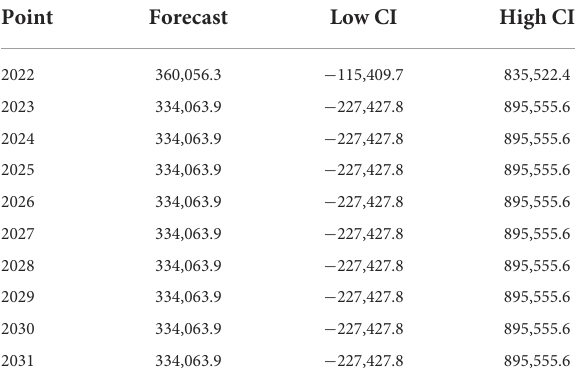
TABLE 1 Out-of-sample forecast at 95% confidence intervals of IDPs annual figures due to conflict and violence (2022–2031). Point Forecast